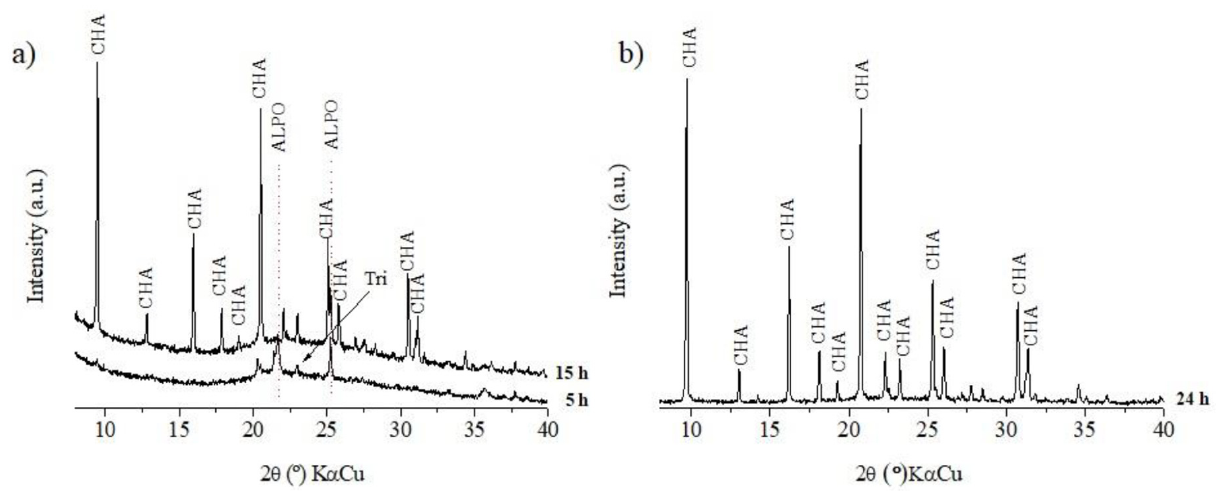
Figure 3. x = 1: ( a ) crystallization time = 5 and 15 h; ( b ) crystallization time = 24 h.